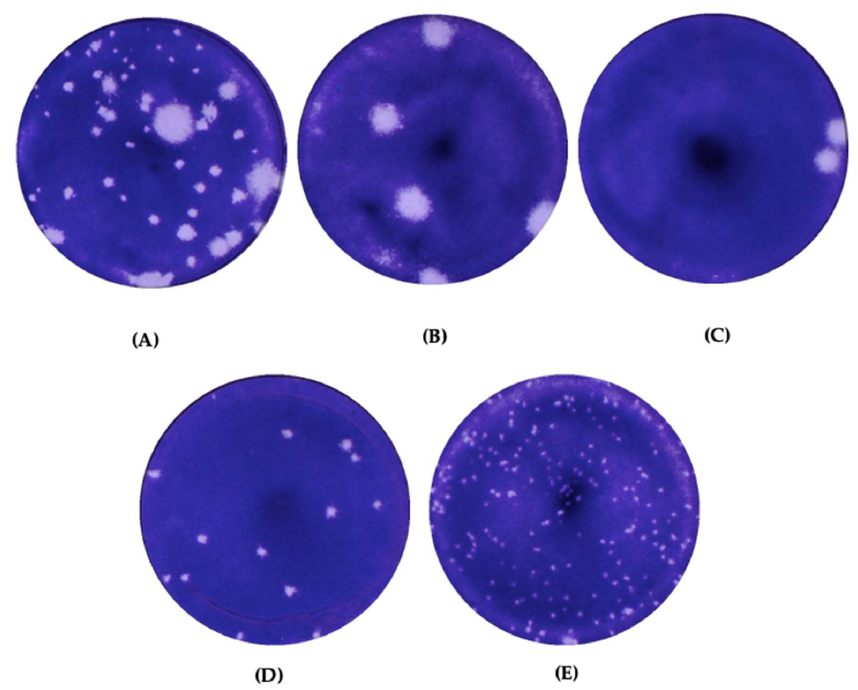
Figure 1. Plaque morphology of ( A ) EV-A71/WT cultured in Rhabdomyosarcoma (RD) cells, ( B ) EV- A71/HP plaque variant, ( C ) EV-A71/BP plaque variant, ( D ) EV-A71/MP plaque variant and ( E ) EV- A71/SP plaque variant. The plaques were visualized 72 h post infection (h.p.i.) after staining with crystal violet. Plaques were observed and images were captured with an Immunospot ® S6 VERSA Analyzer (Cellular Technology Limited, USA).